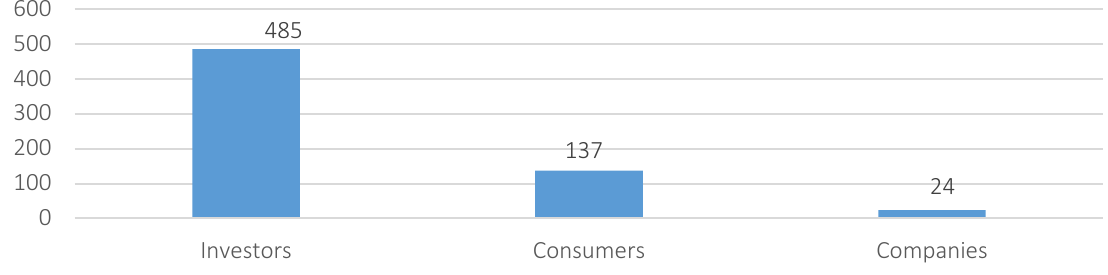
Figure 4. Target audience of sustainability ratings in 2017